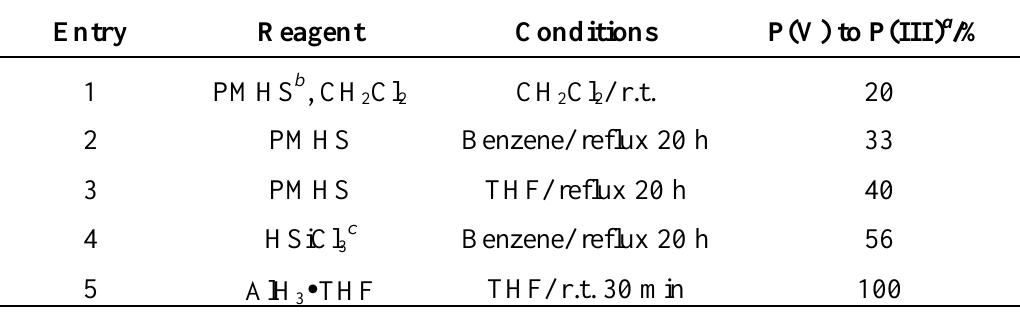
Table 3. Regeneration of PEG-supported triarylphosphine 2